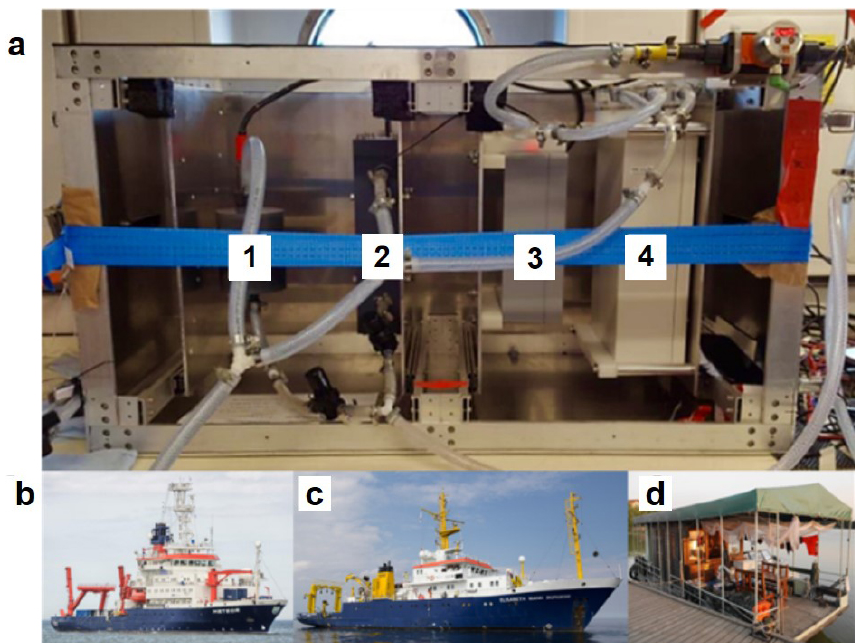
Figure 2. Complete flow-through set-up (a) in operation on board RV Meteor , indicating the easily accessible sensors for O 2 (1), T and S (2), and p CO 2 (3) and CH 4 (4). Besides the operation on RV Meteor , M133, (b) across the Atlantic, the set-up was also deployed on RV Elisabeth Mann Borgese , EMB 142, (c) within the Baltic Sea and on a houseboat in the Danube Delta (d) , Romania, for spring (Rom1), summer (Rom2) and autumn